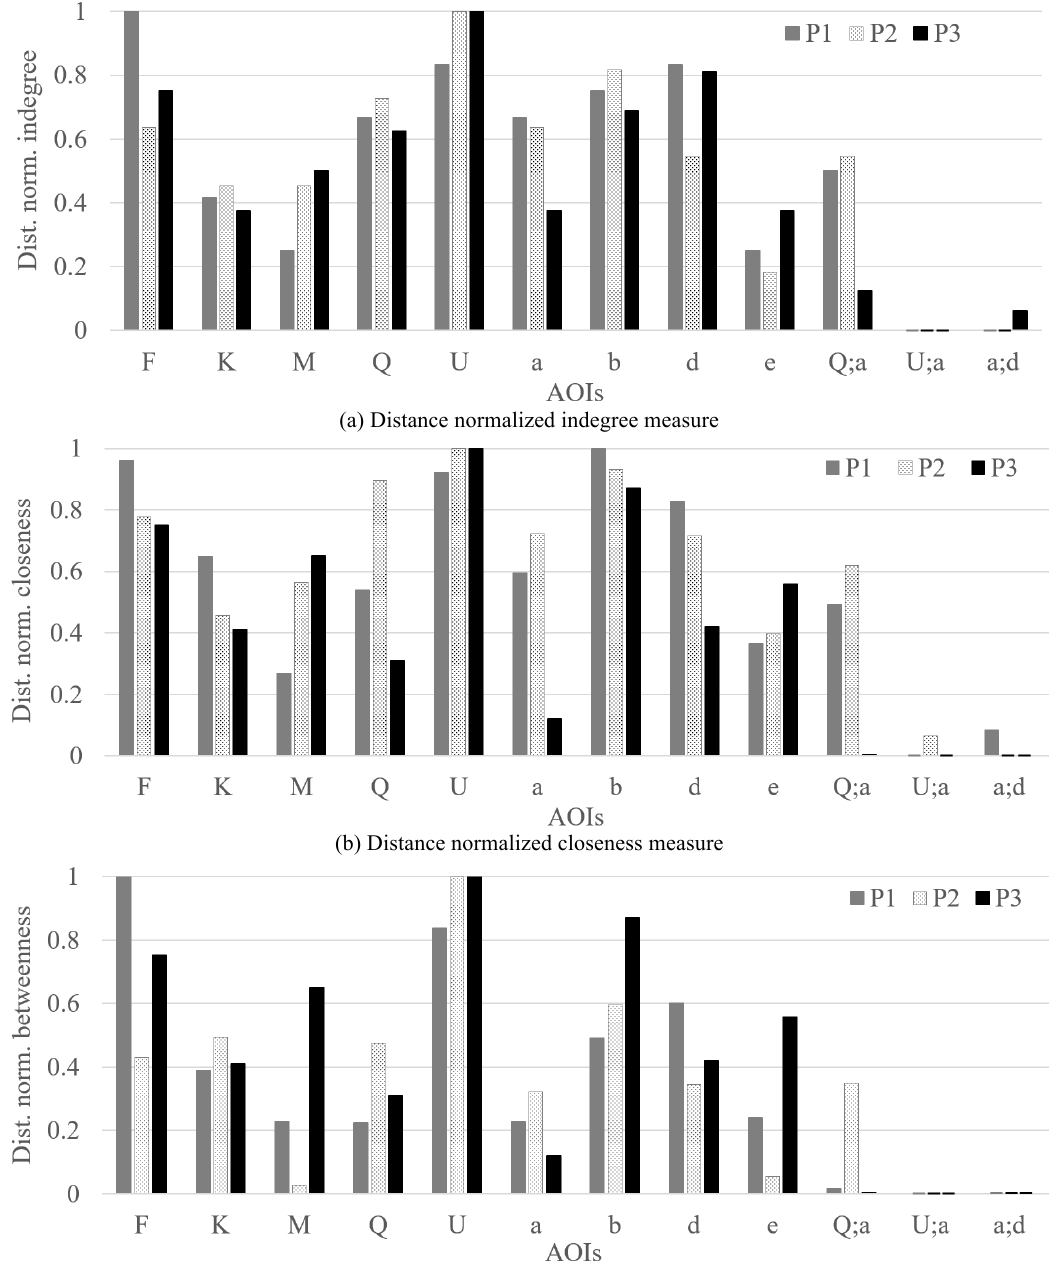
Figure 11. Comparison of three ATCS’s visual scanning strategy by analyzing the distance normalized importance measure values of AOIs. The Figures (a), (b), and (c) shows the relative importance of AOIs in terms of distance normalized indegree, closeness, and betweenness value (as shown by their zero values in the vertical axis in Figure